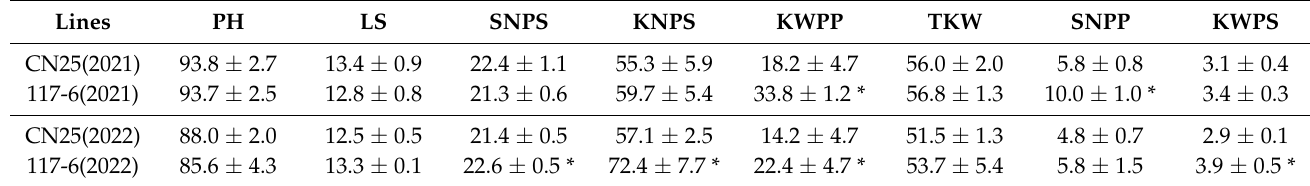
Table 3. Comparisons of agronomic traits between 117-6 and its wheat parent